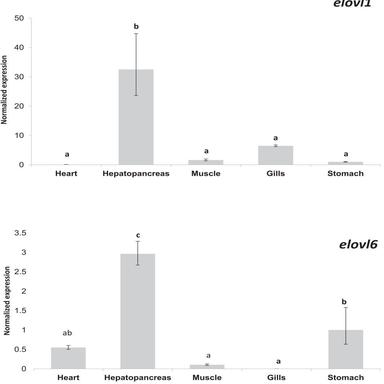
Tissues distribution of transcripts of the G. lalandii elovl1 and elovl6. Expression levels of the target genes was normalised to that of ef1a (N = 3) The different letters indicate statistically significant differences (P < 0.05; Tukey's test).